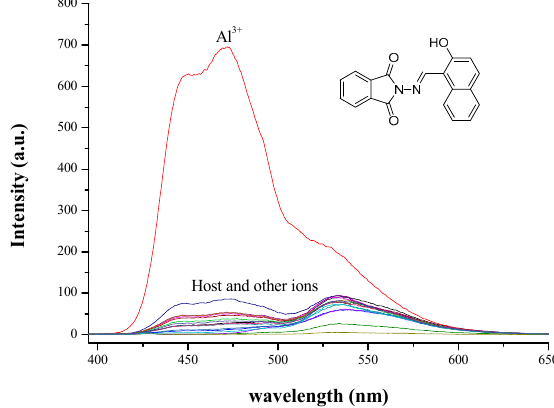
Figure 3. Fluorescence emission spectra for probe L (40 μΜ ) in the presence of 5 equiv. of various metal ions in DMSO-H 2 O (1:9 v/v).